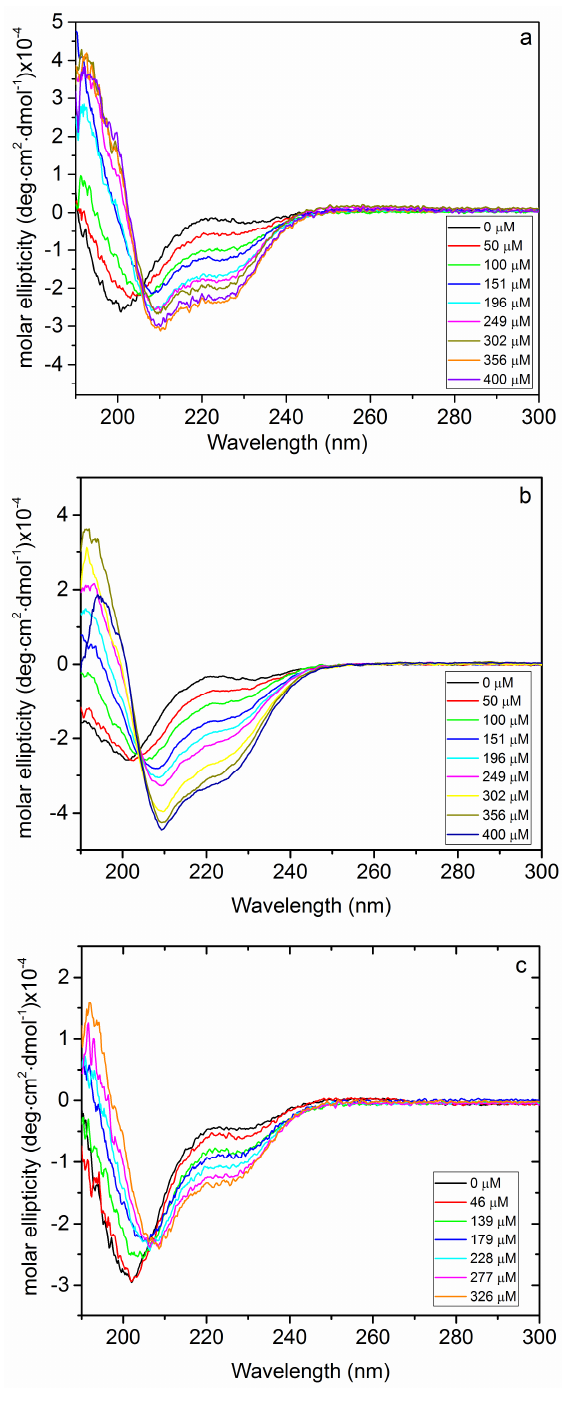
Figure 1. Circular dichroism (CD) spectra of BMAP-27 as a function of increasing extracellular polysaccharide (EPOL) concentrations. ( a ) KpTs101; ( b ) KpTs113; ( c ) KpMn7. Polysaccharide concentrations are indicated. [BMAP-27] = 20 μM, T = 25 °C, phosphate buffer.